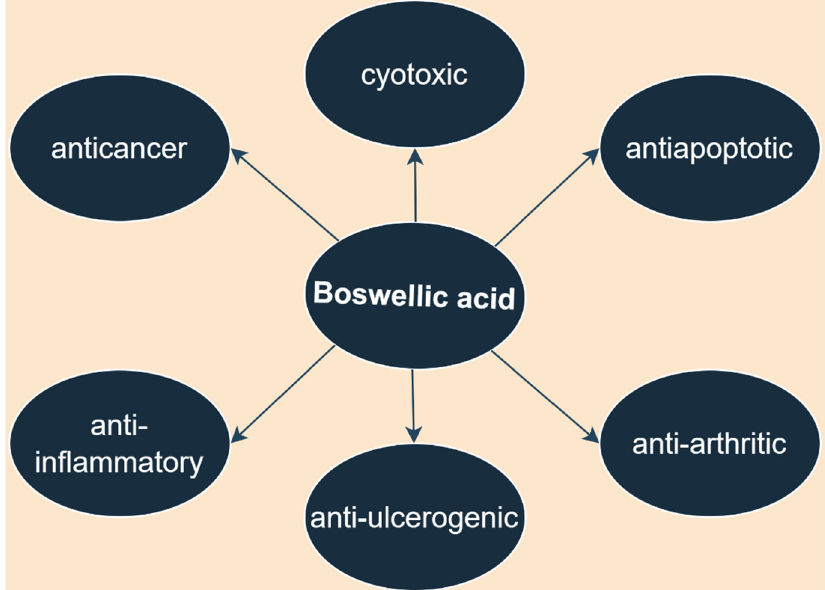
Figure 7. Biological activities of boswellic acid. Parts of the figure were drawn by using